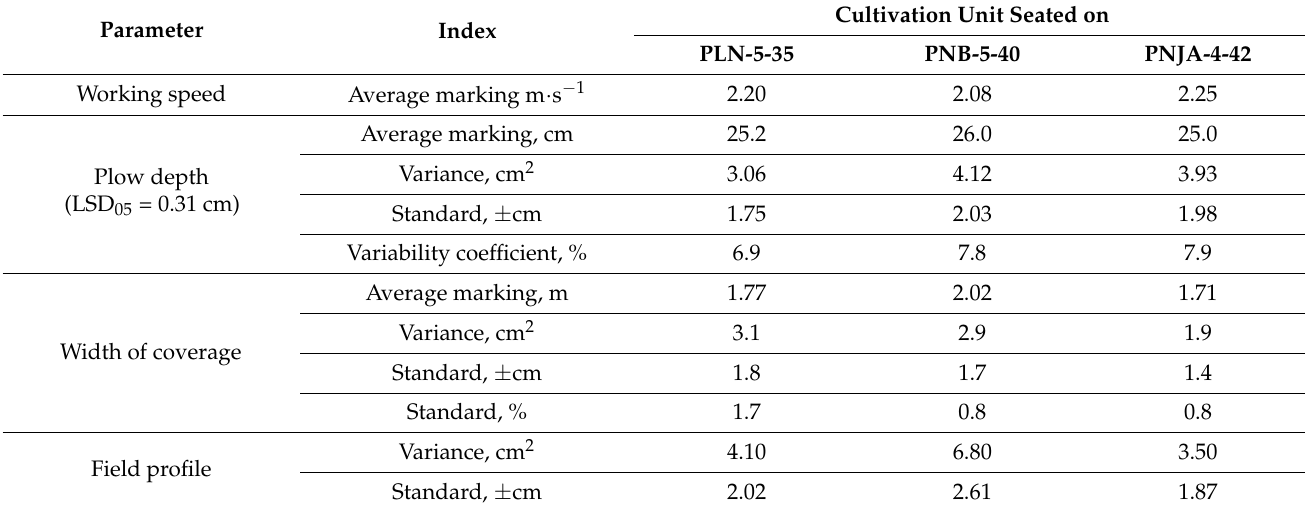
Table 3. Indices of efficiency of the plows